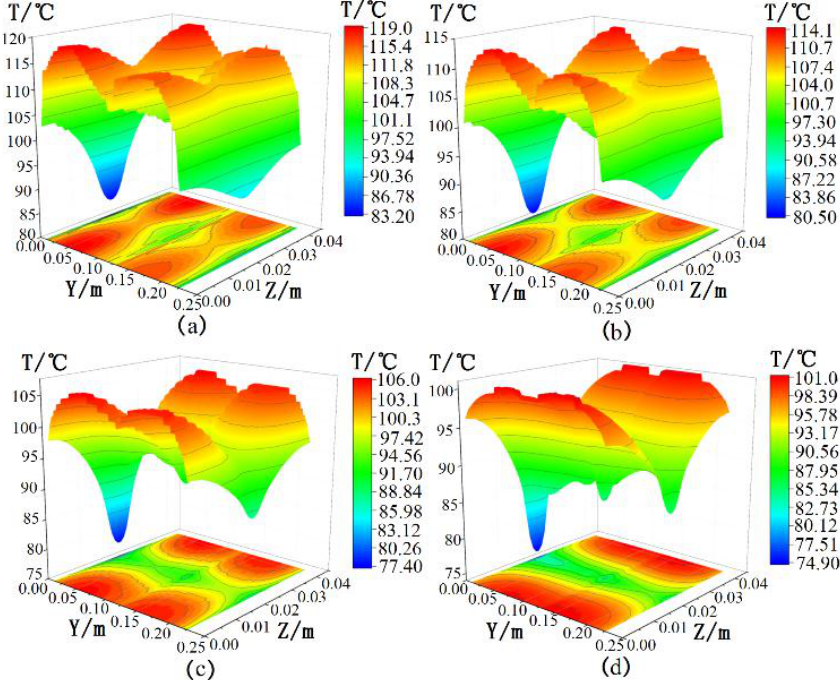
Figure 5. In the case of the stator main insulation unilateral shelling δ = 0.5 mm, the main insulation axis–radial temperature distribution in the shelling side: ( a ) The main insulation axial–radial P 5 temperature distribution; ( b ) The main insulation axial–radial P 6 temperature distribution; ( c ) The main insulation axial–radial P 7 temperature distribution; ( d ) The main insulation axial–radial P 8 temperature distribution.